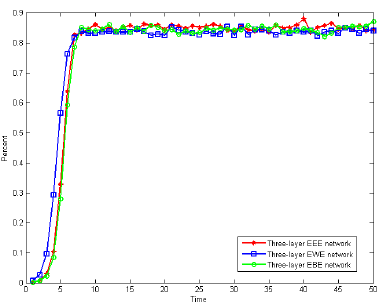
Figure 6. The spreading trends of three kinds of three-layer complex network under the same average degree.